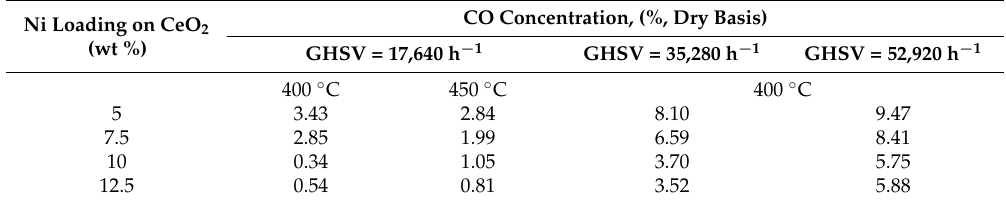
Table 5. CO concentrations at the reactor outlet at different